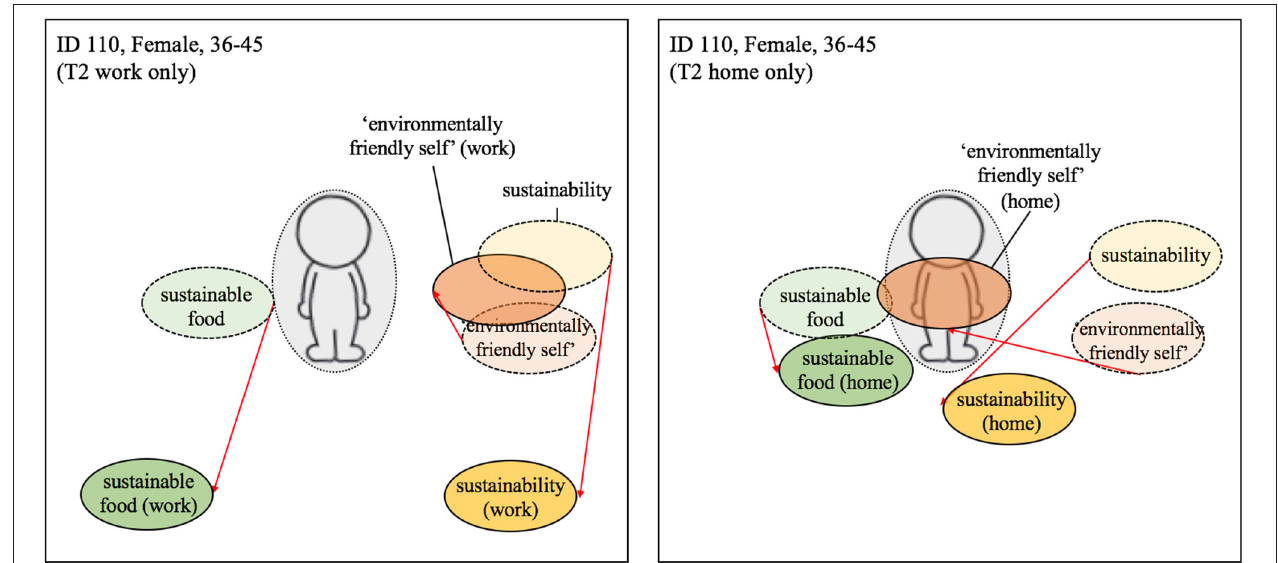
FIGURE 8 | Visualization of centrality of identity—Compartmentalization of work and home. Dashed line = T1; solid line and darker coloring = T2; Red arrow indicates change from T1 to T2 (the colors were added after the analysis). Participant differentiated between self at work and home at T2.